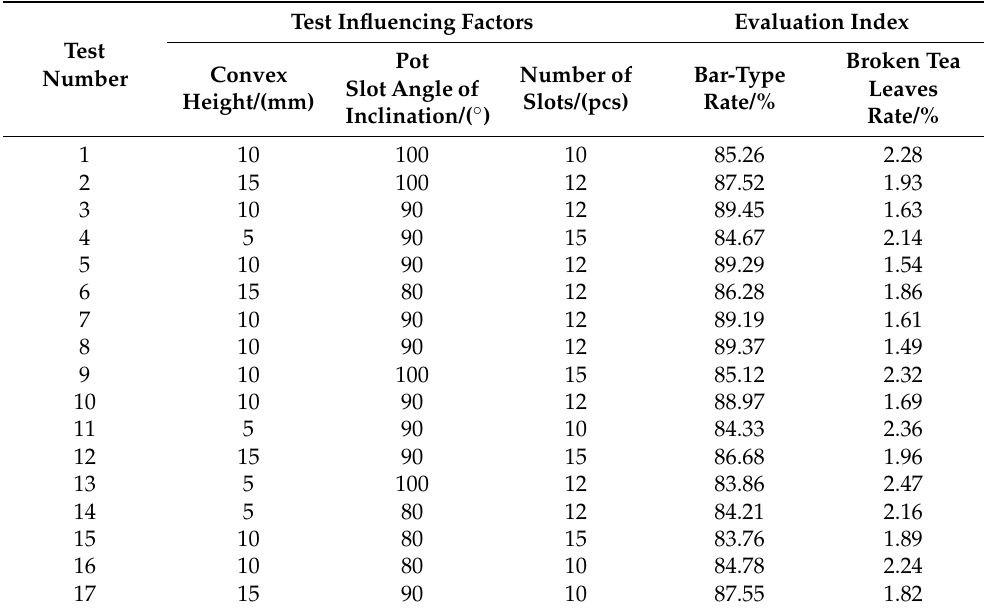
Table 4. Calculation